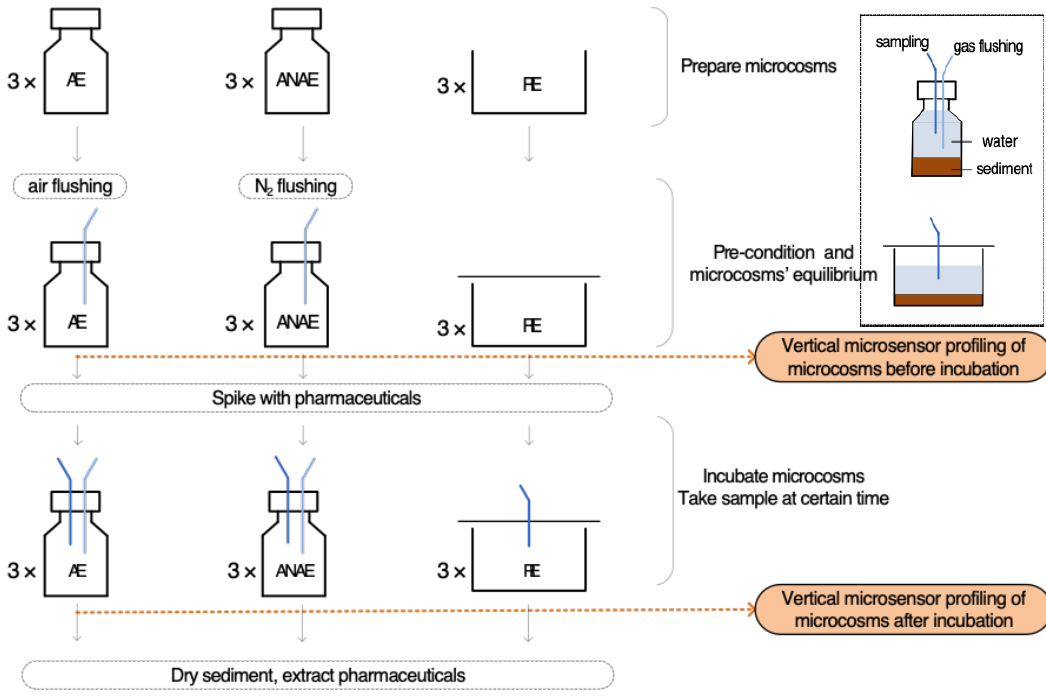
Figure 1. Schematic diagram of the process of the microcosm experiment ( left ) and experimental reactors for AE, ANAE and RE microcosms ( right ).